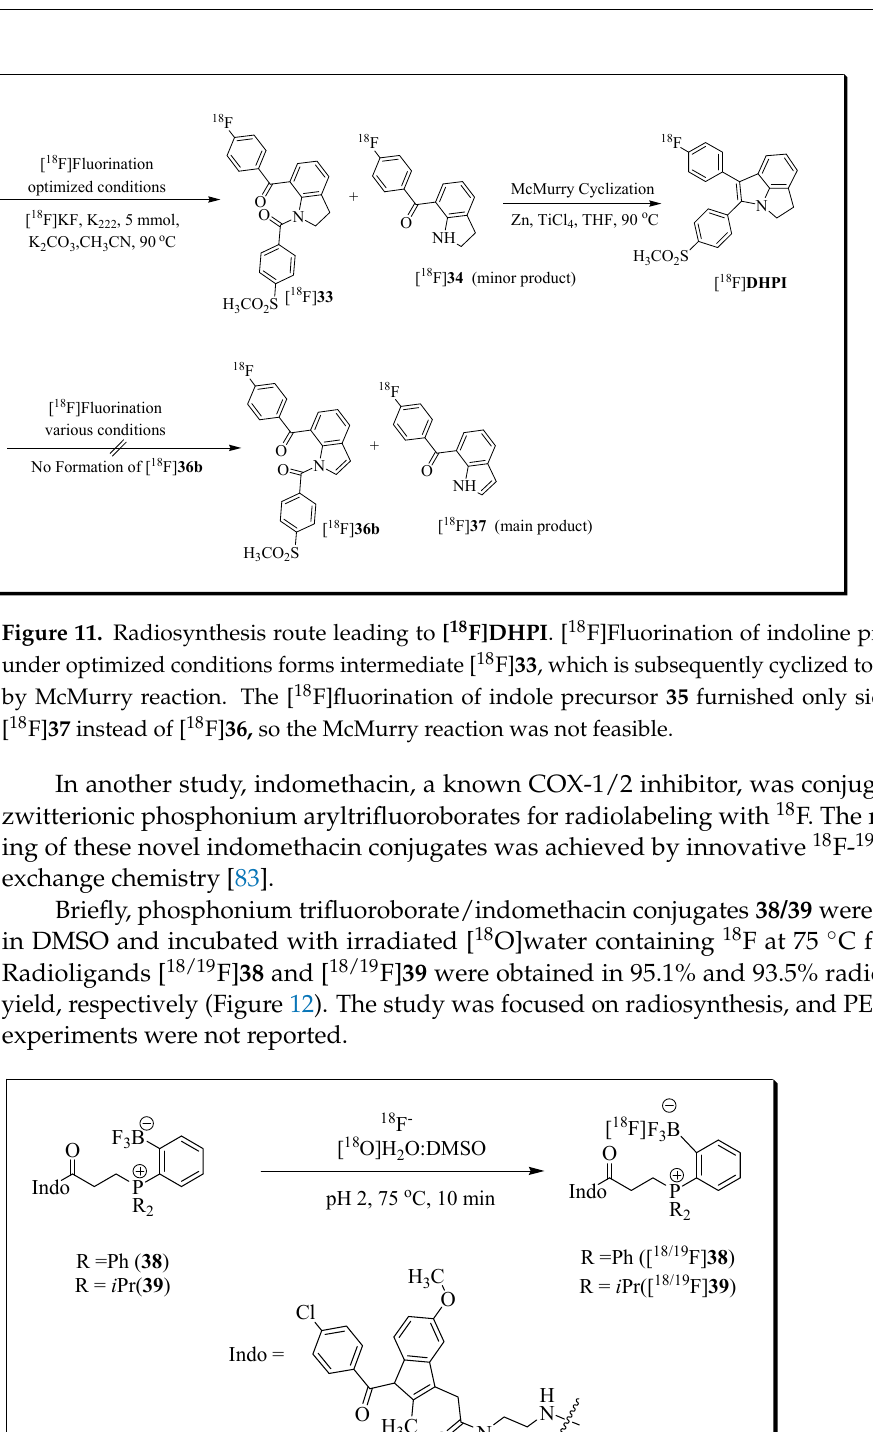
Figure 12. Scheme showing the radiolabeling of 38 and 39 by isotopic exchange in an aqueous solu- tion.